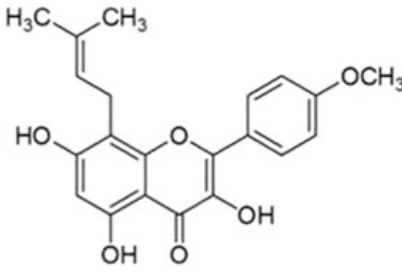
Figure 1. Chemical structure of icaritin.